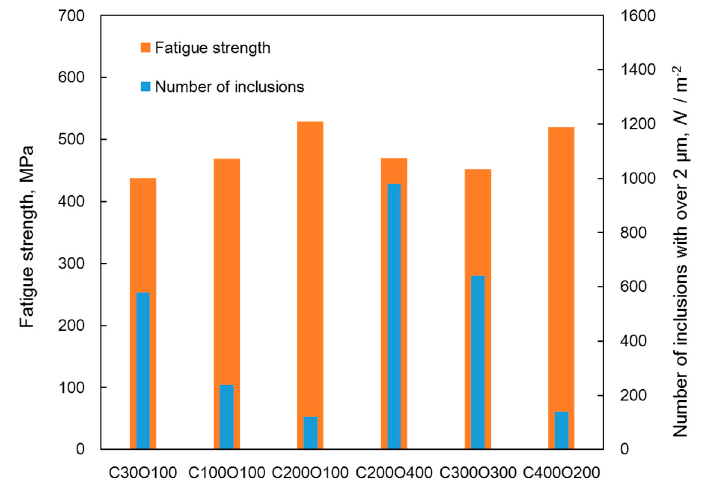
Figure 8. Relation between the fatigue strength and the number of nonmetallic inclusions of > 2 µ m in length parallel to the wire drawing direction.